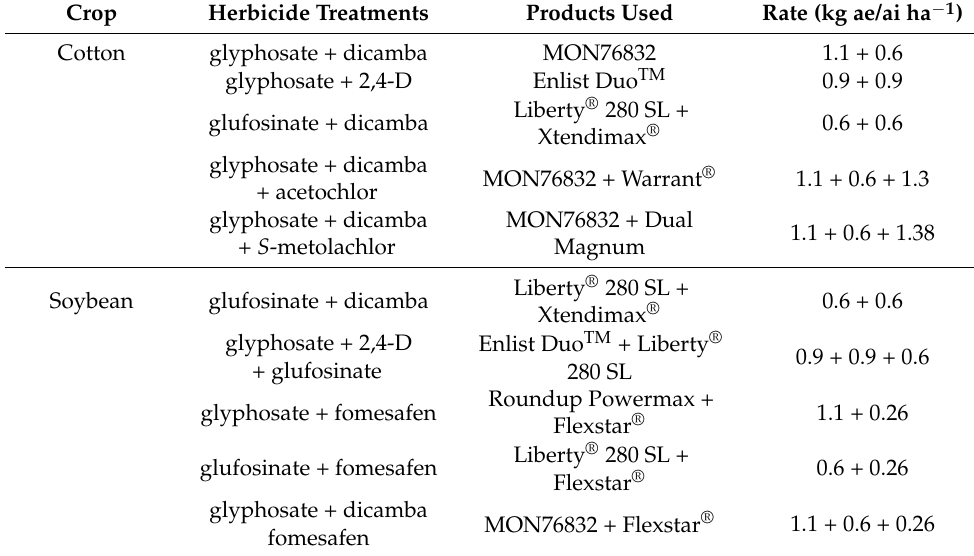
Table 1. Herbicide tank-mixtures tested in the cotton and soybean spray deposition